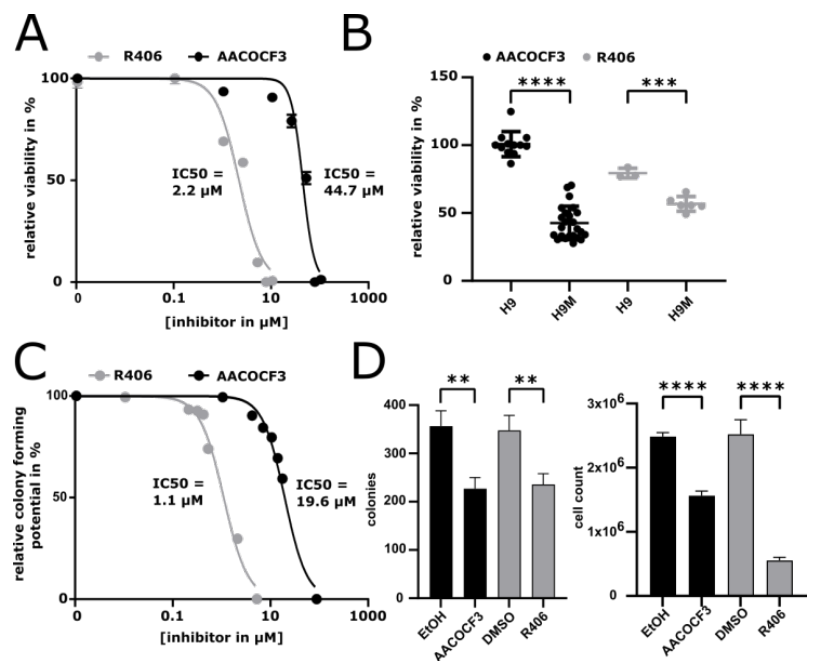
Figure 5. Pharmacologic inhibition of PLA2G4A specifically impairs H9M cell growth. ( A ) Determination of the IC50 of the PLA2G4A inhibitor AACOCF3 (44.7 µ M) and the SYK inhibitor R406 (2.2 µ M) based upon viability of H9M cells determined with the resazurin-based alamarBlue assay. Viability was normalized to H9M cells treated with DMSO or EtOH as a vehicle control (dose response curve, n = 7). ( B ) alamarBlue viability assay of H9M and H9 cells after 24 h exposure with AACOCF3 (44.7 µ M) and R406 (2.2 µ M), respectively. Viability was normalized to H9M/ H9 cells treated with a vehicle control (DMSO/ EtOH). Both inhibitors showed a significant loss of viability of H9M cells compared to H9 cells (Scatter dot plot, Student’s t -test, mean ± SD: AACOCF: mean relative viability H9 = 100.8% ( n = 12), H9M = 42.66% ( n = 24), p = <0.0001; R406: H9 = 79.44% ( n = 3), H9M = 56.74% ( n = 6), p = 0.0003). ( C ) Determination of the colony-forming potential (CFP) IC 50 of AACOCF3 (19.6 µ M) and R406 (1.1 µ M) in H9M cells using the methylcellulose colony-forming assay (CFA). Colony-forming potential was normalized to H9M cells treated with DMSO or EtOH as a vehicle control (dose response curve). ( D ) 500 H9M cells were seeded in a CFA with R406 (1.1 µ M), AACOCF3 (19.6 µ M) or a vehicle control (DMSO/ EtOH). Experiments were performed in duplicates of three independently generated H9M lines. Both inhibitors caused a significant reduction in colonies (mean ± SD, n = 3, Student’s t -test: AACOCF3: p = 0.0045, R406: p = 0.0071) and absolute cell numbers (mean ± SD, n = 3, Student’s t -test, AACOCF3: p < 0.0001, R406: p = 0.0001) compared to the vehicle control. ** = p < 0.005; *** = p < 0.0005; **** = p < 0.0001.